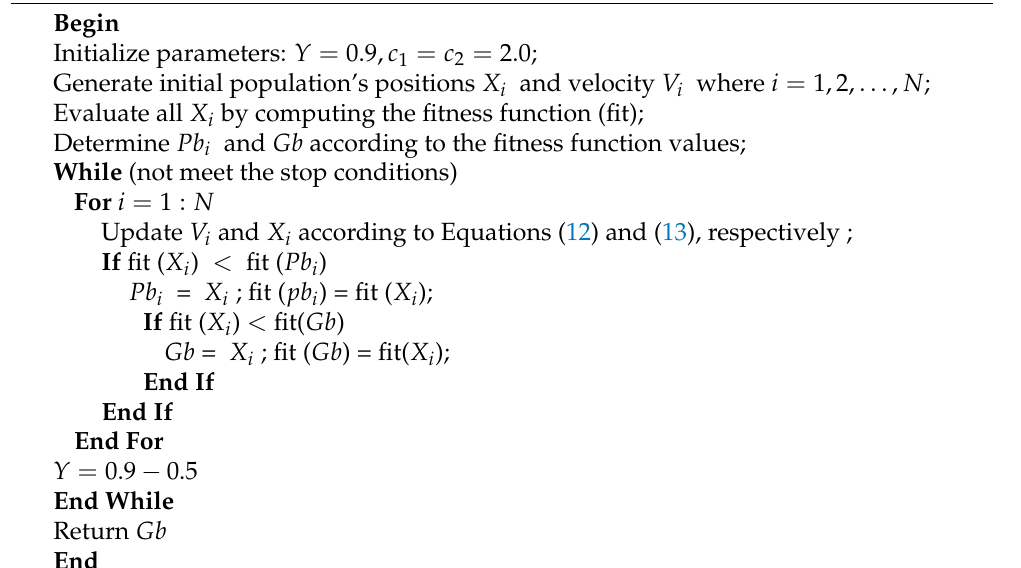
Algorithm 1 Pseudo-code of the PSO